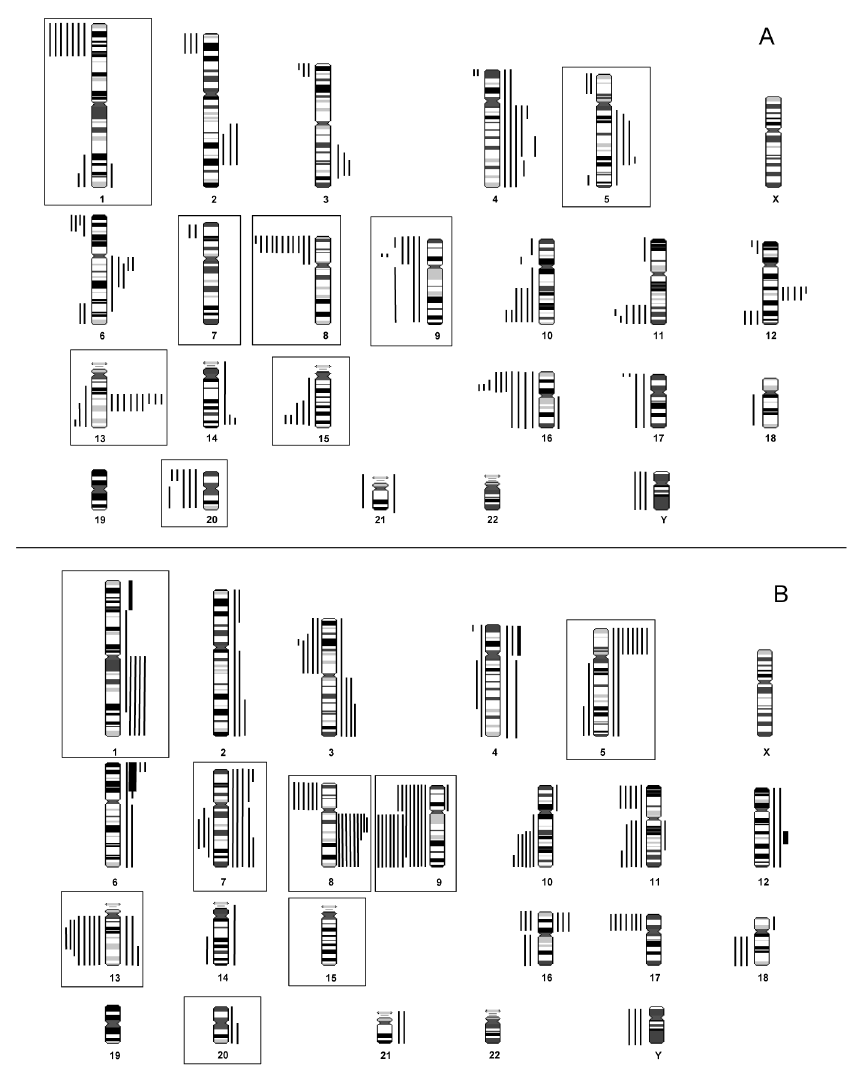
Figure 1. Superkaryogram of 29 CDC (A) and 26 UUT-UC (B) tumors. Losses of DNA are shown as lines on the left sides of chromosome ideograms, gains on the right side. High-level amplifications (amplicons) are shown as thick bars at the corresponding chromosome regions. Significant differences are highlighted by orange boxes. doi: